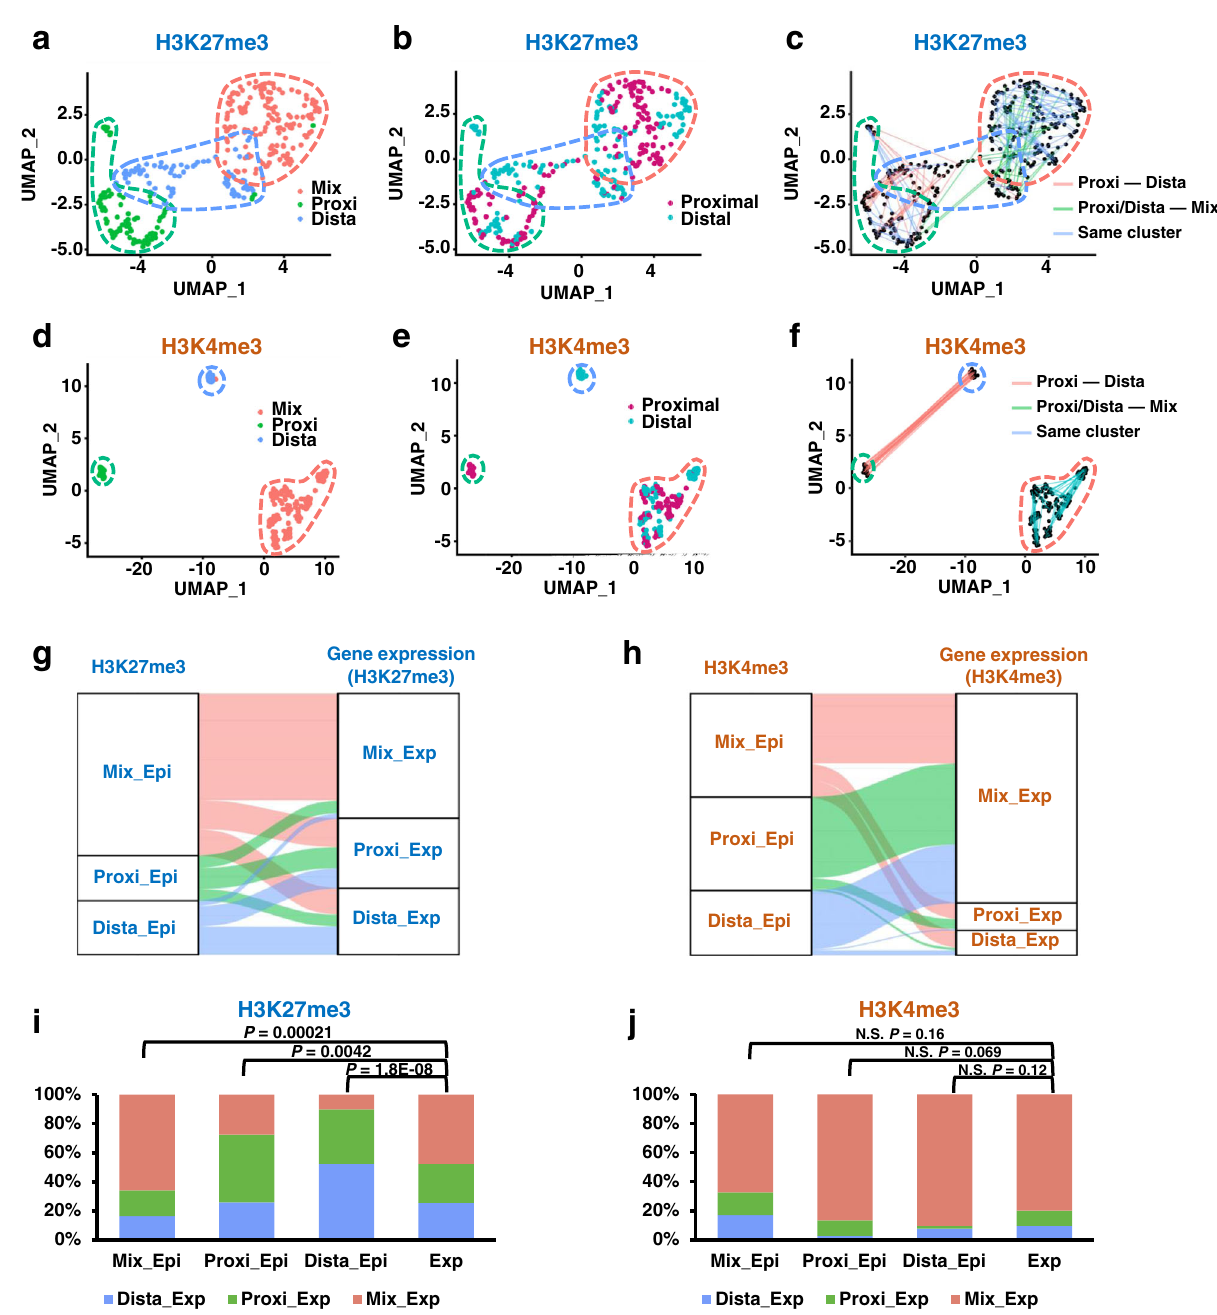
Fig. 5 Cells clustered by H3K27me3 recapitulate their distributions clustered by gene expression. a UMAP embedding showing the clustering of cells from H3K27me3 scSET-seq by H3K27me3 signals. Each dot represented a single cell. The cluster with a majority of proximal cells was de fi ned as the Proxi cluster, with abundant distal cells was de fi ned as the Dista cluster, and with mixed proximal and distal cells was de fi ned as the Mix cluster. b Colored map showing the relative position of cells to Wnt3a beads in H3K27me3 scSET-seq. Cells proximal to beads were marked garnet and distal to cells were marked cyan. c Line maps showing the paired daughter cells among cell clusters in H3K27me3 scSET-seq. Red lines indicated the paired cells were between Proxi and Dista cluster, green lines indicated the two daughter cells were between Proxi/Dista cluster and Mix cluster, and blue lines connected cells inside the same cluster. d Same as in a , except H3K4me3 scSET-seq was analyzed. e Same as in b , except H3K4me3 scSET-seq was analyzed. f Same as in c , except H3K4me3 scSET-seq was analyzed. g Sankey plots showing the cell identities classi fi ed by H3K27me3 and joint transcriptional pro fi les. Epi, cell clusters de fi ned by epigenetic pro fi les. Exp, cell clusters identi fi ed by gene expression pro fi les. h Sankey plots showing the cell identities classi fi ed by H3K4me3 and joint transcriptional pro fi les. i Bar graph showing the percentage of cells projected by gene expression pro fi les from H3K27me3 scSET-seq. Cell clusters identi fi ed by H3K27me3 were shown as the x -axis. Exp, the percentage of cells classi fi ed by corresponding gene expression was used as a negative control. P values were calculated by Student ’ s t -test, two-sided. j Same as in i , except H3K4me3 scSET-seq data were analyzed. N.S. Not Signi fi cant. Source data are provided as a Source Data fi